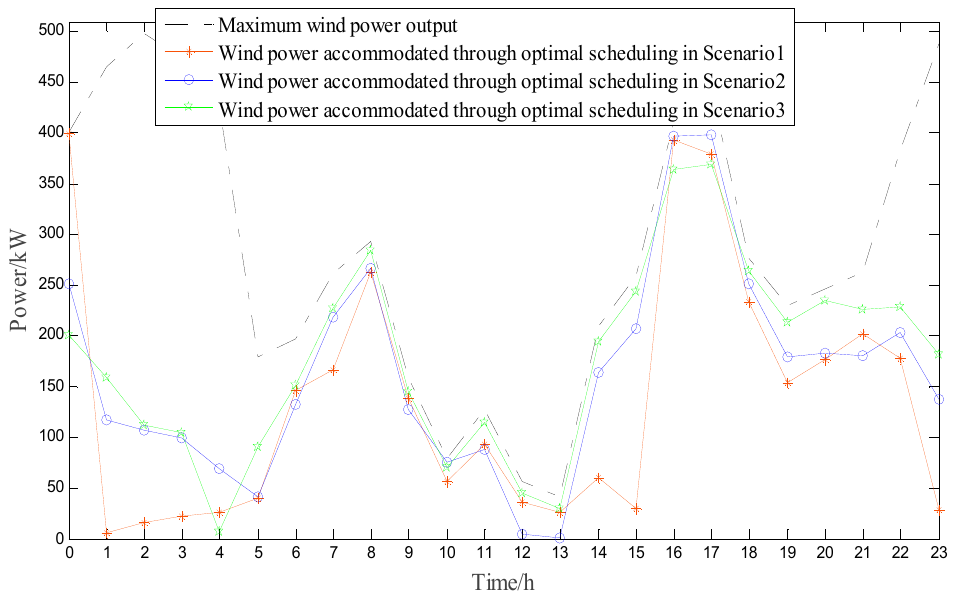
Figure 11. Wind power consumption by internal load of combined heat and power (CHP) system in different scenarios.